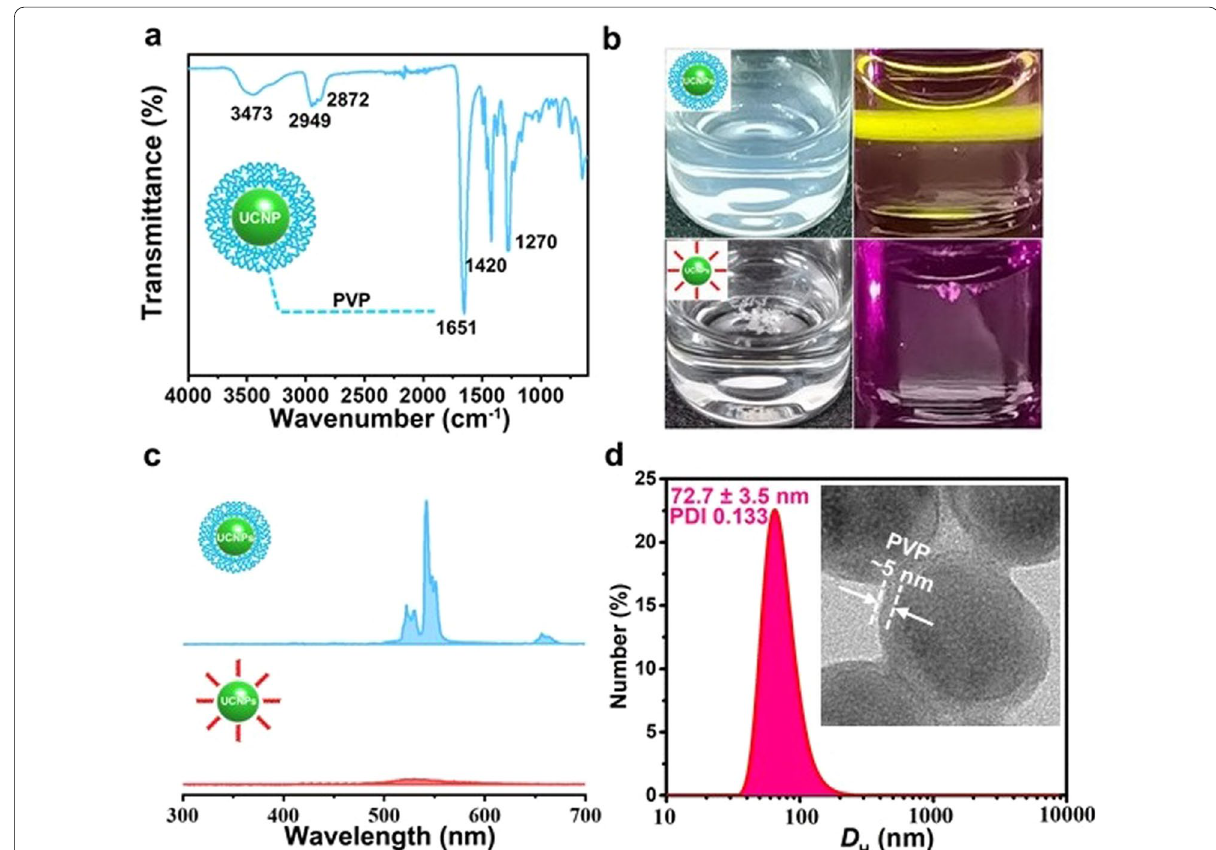
Fig. 2 a The ATR-FTIR spectrum of PVP-UCNPs. b Digital images showing UCNPs in water (upper row: PVP-UCNPs, bottom row: OA-UCNPs) upon normal light conditions (left column) and an 808 nm laser exposure (right column). c Upconversion emission spectra of OA-UCNPs (red line, bottom) and PVP-UCNPs (cyan line, upper) in water. d The size distribution as revealed by DLS for PVP-UCNPs in H 2 O (~ 1 mg mL − 1 ). The inset figure shows the TEM image of